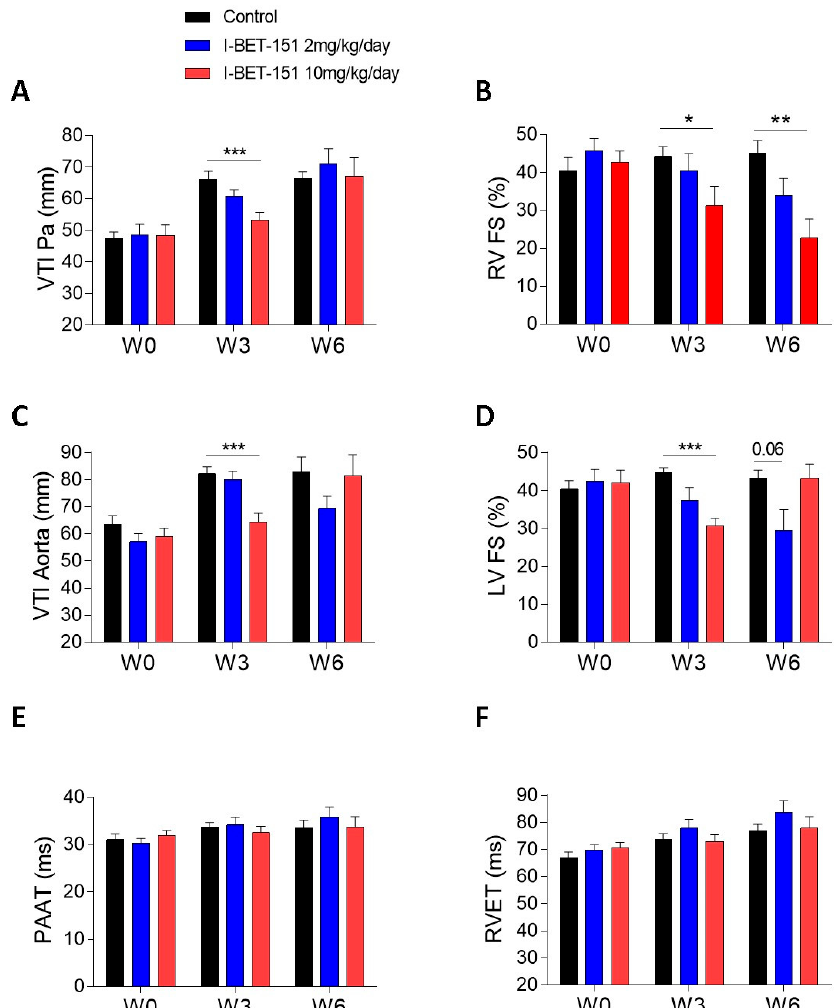
Figure 5. Effect of I-BET-151 on heart function assessed by echocardiography. Velocity-time-integral (mm) in the pulmonary artery ( A ). Right ventricular fractional shortening (%) ( B ). Velocity-time-integral in the aorta (mm) ( C ). Left ventricular fractional shortening (%) ( D ). Pulmonary artery acceleration time (ms) ( E ). Right ventricular ejection time (ms) ( F ). Between six and 12 rats per group (12 at baseline and W3, six at W6). W0: baseline, W3: Week 3, 3 weeks of exposure to I-BET-151 or vehicle only; Week 6: 3 weeks of exposure to I-BET-151 or vehicle only followed by 3 weeks of drug wash out. * p < 0.05, ** p < 0.01, and *** p < 0.01 as compared to control group (at W0, W3, or W6).